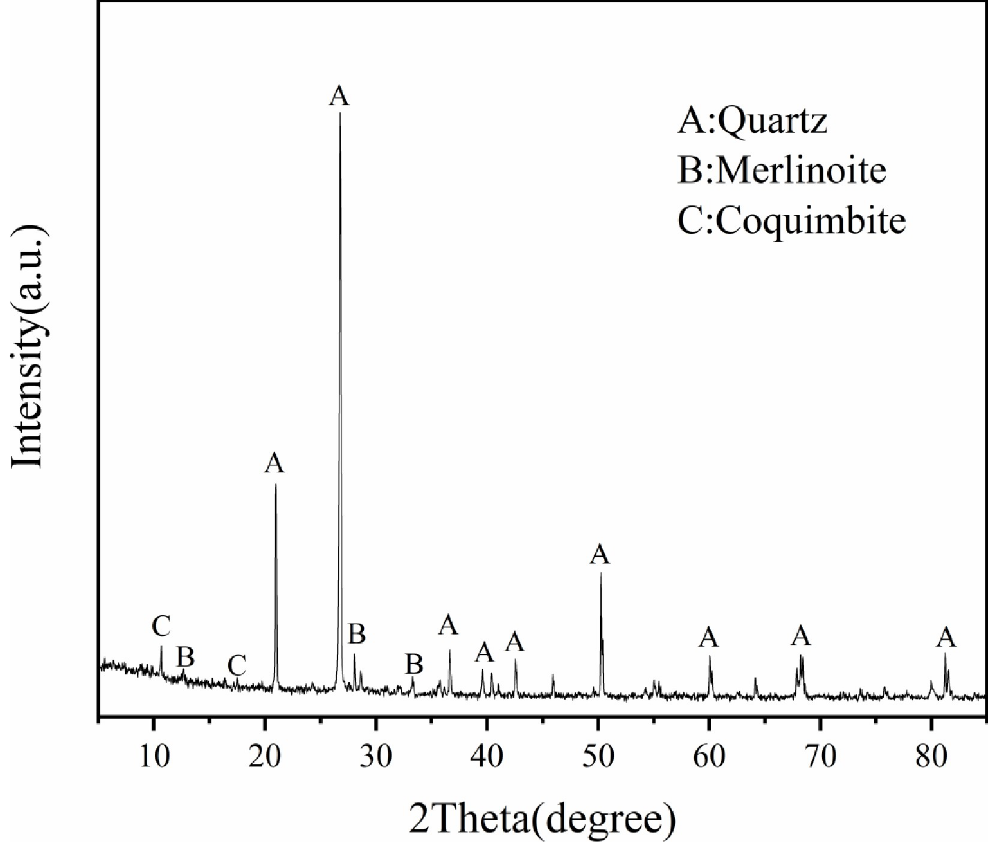
Fig 1. XRD spectrum of